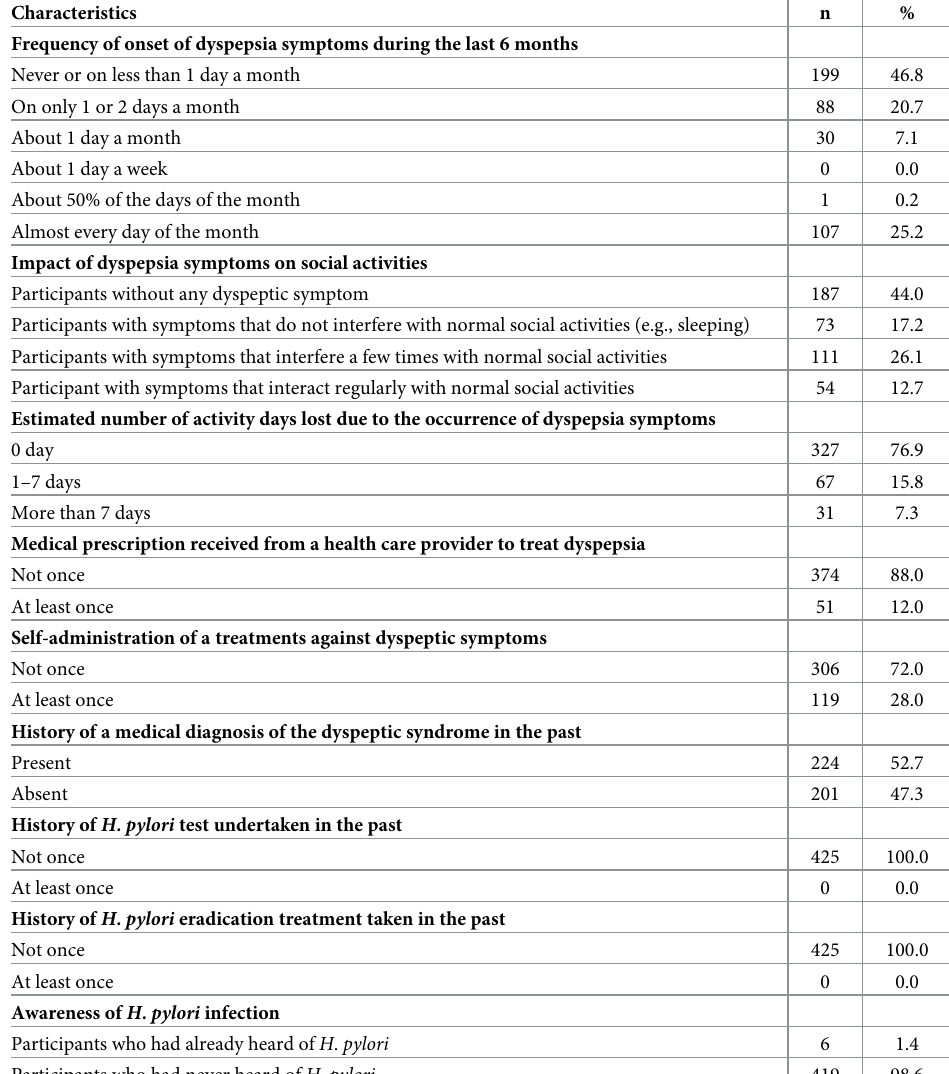
Table 7. Characterization of the dyspepsia in study